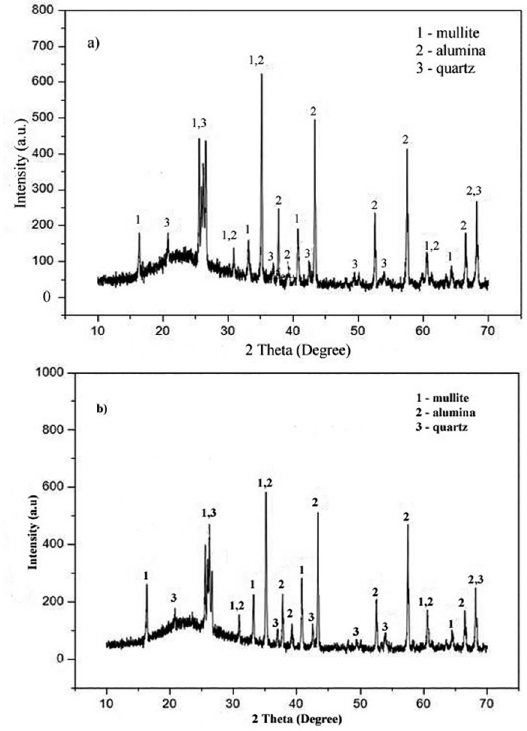
Figure 2. X-ray diffraction patterns of the porcelain pieces fired at 1300 ºC: (a) TF0 formulation; and (b) TF30 formulation. SEM micrographs of the fracture surfaces of the TF10 and TF30 formulations fired at 1300 ºC using a fast-firing